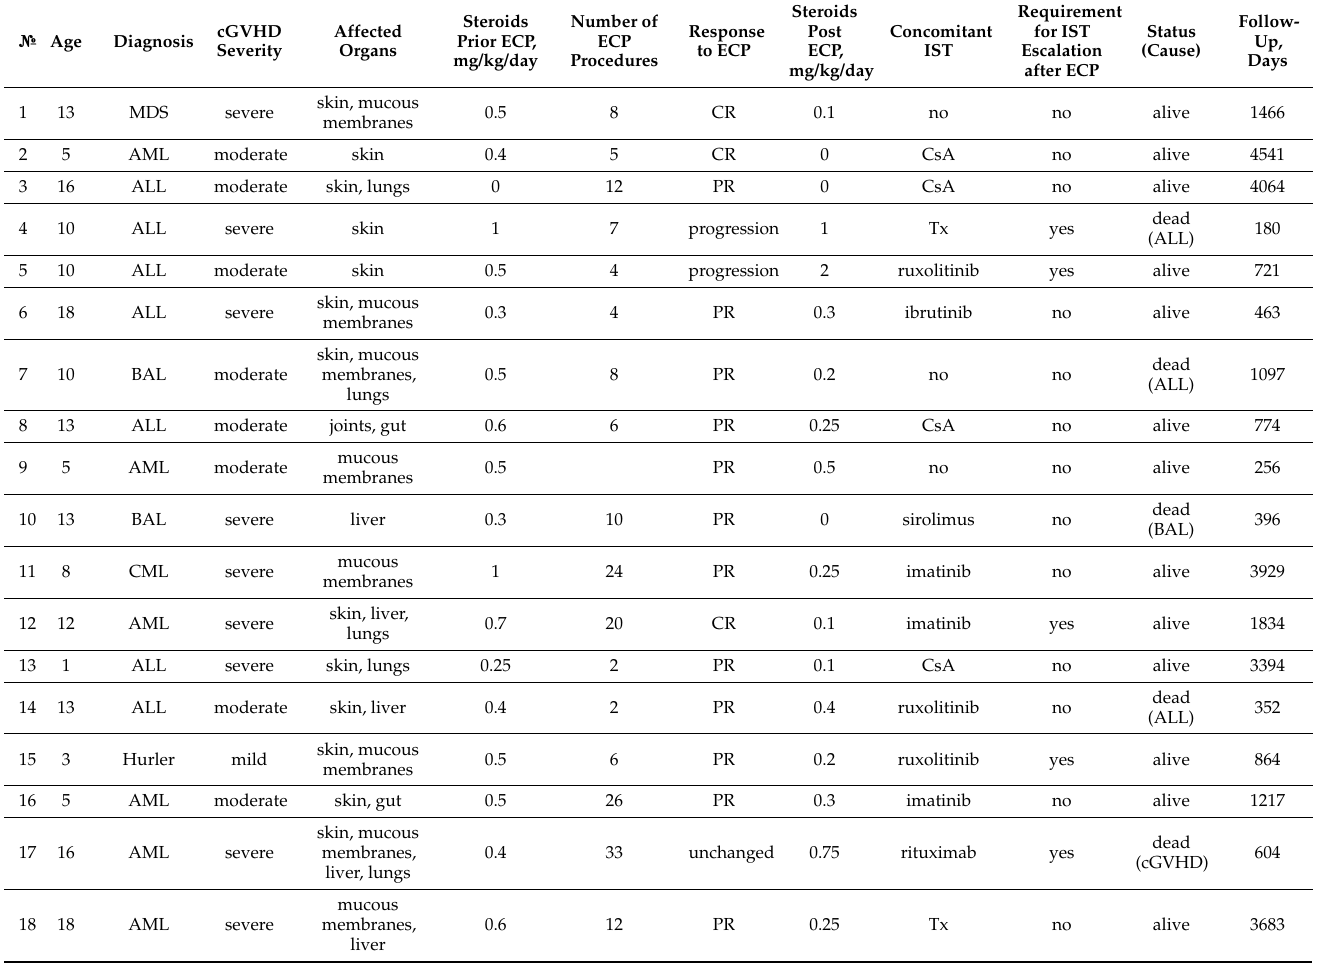
Table 1. Demographics of patients with cGVHD treated with